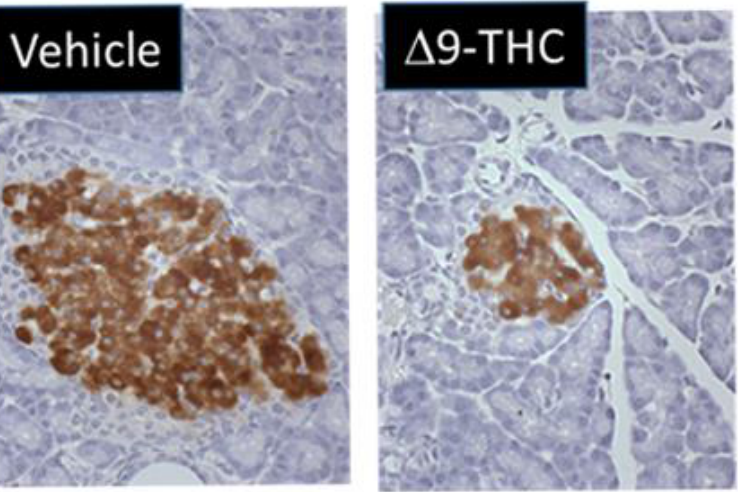
Figure 1. Maternal exposure to 3 mg/kg THC i.p. daily from gestational day 6–22 leads to reduced pancreatic islet size at 5 months in female offspring. Representative immunohistochemistry of pancreatic islets immunostained for insulin from vehicle and THC rat offspring.